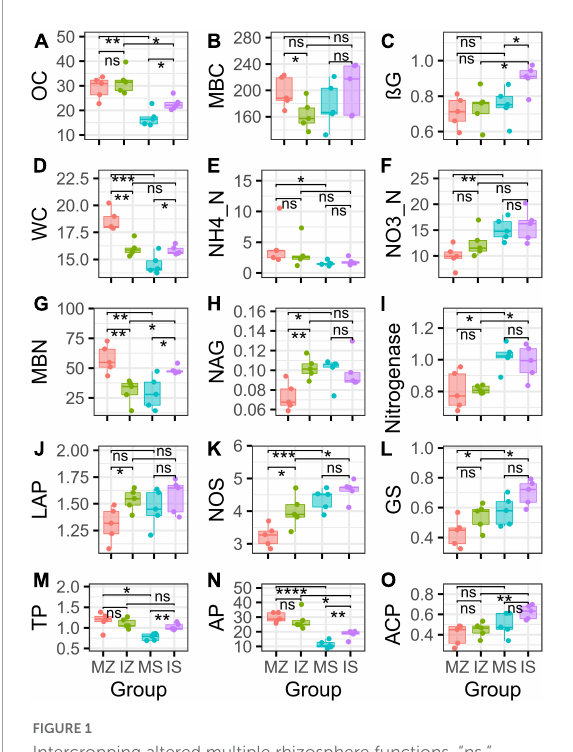
FIGURE1 Intercropping altered multiple rhizosphere functions.